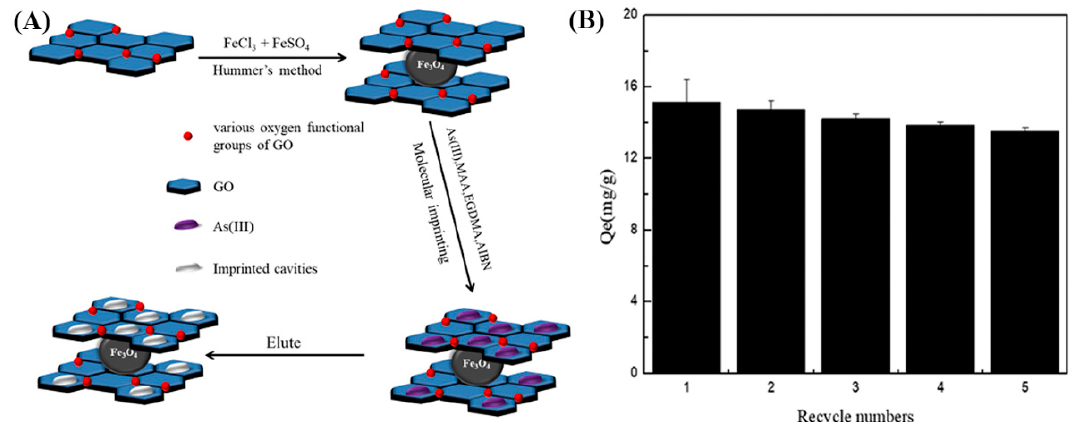
Figure 8. ( A ) Schematic for the synthesis of MGO − As(III) − IIP; ( B ) effect of regeneration cycles on the adsorption capacity. Reprinted with permission from [90]. Copyright@ Elsevier.